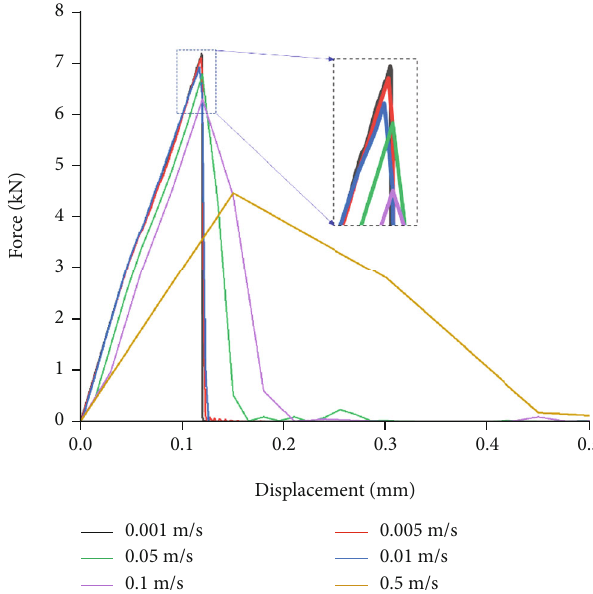
Figure 4: Numerical model con fi guration.